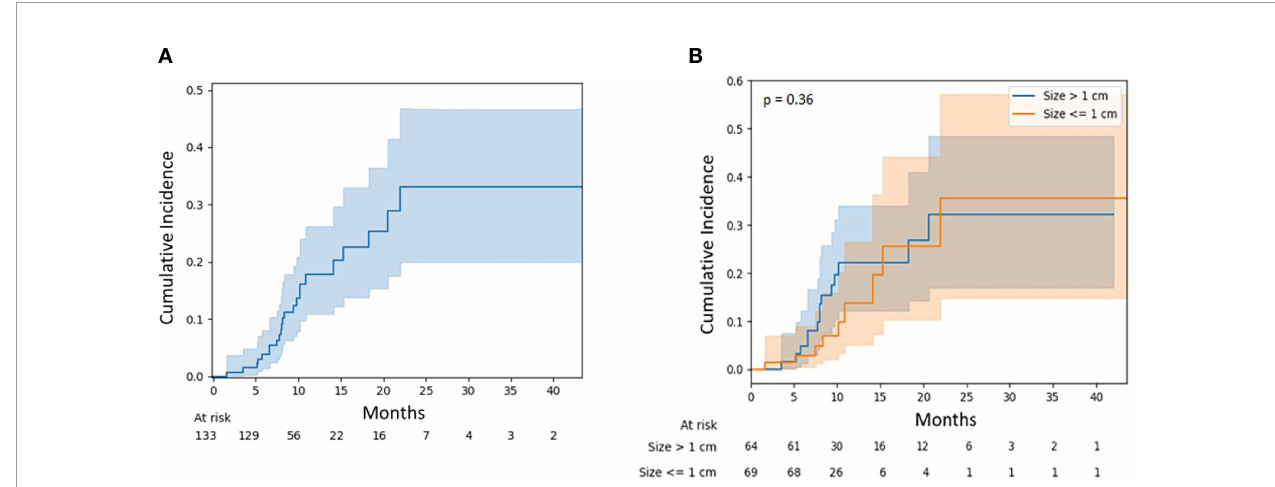
FIGURE 2 | (A) Local failure for all lesions. (B) Local failure for lesions strati fi ed by diameter: ≤ 1 vs. >1